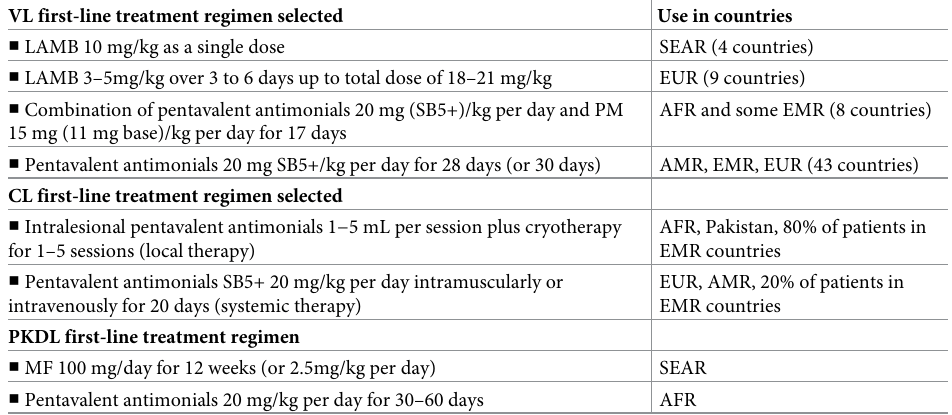
EUR (9 countries) AFR and some EMR (8 countries) AMR, EMR, EUR (43 countries) AFR, Pakistan, 80% of patients in EMR countries EUR, AMR, 20% of patients in EMR countries